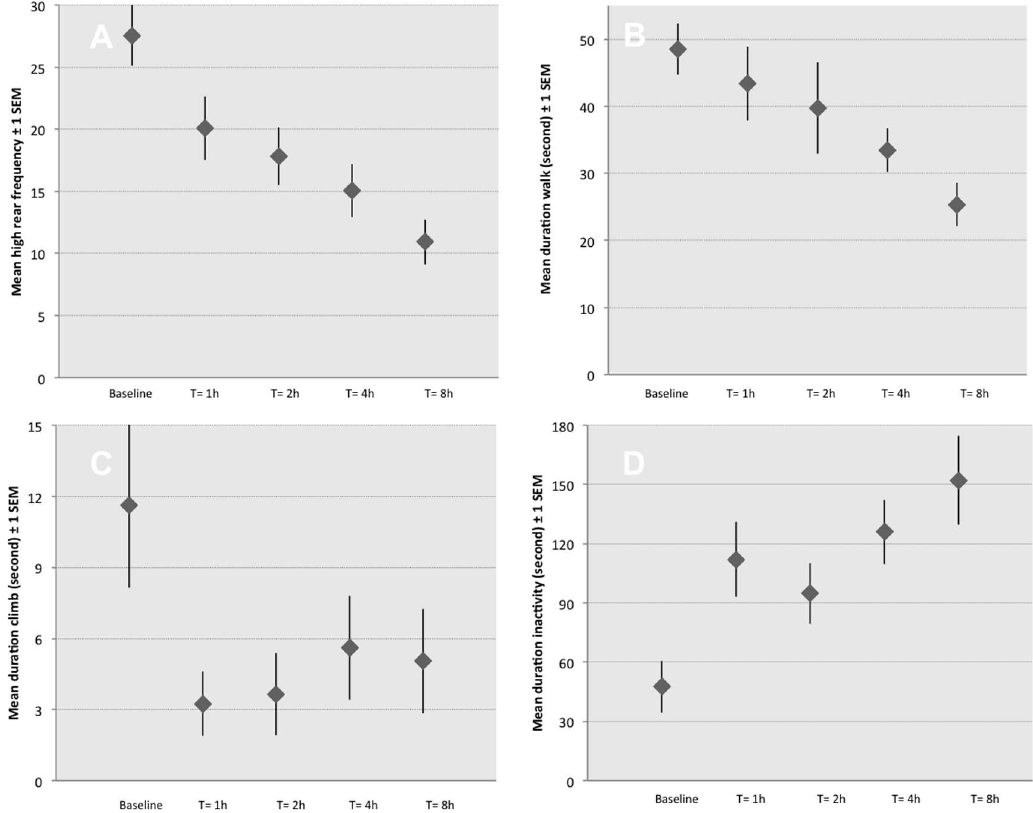
Fig 2. Representation of mean duration or frequency of the most commonly observed behaviours in pain-free rats (1 st phase study) ± 2 standard error to the mean. N = 24, pooleddata for treatment groups 1.1 to 1.4. There was no significant treatment effect between groups. A : significant decrease of rearing frequency over time (p < 0.001); B : significant decrease of time spent walking over time (p < 0.001); C : Time spent climbing is significantly higher at baselinethan at any further time point (P = 0.036); D: significant increase of the time spent inactive (p =